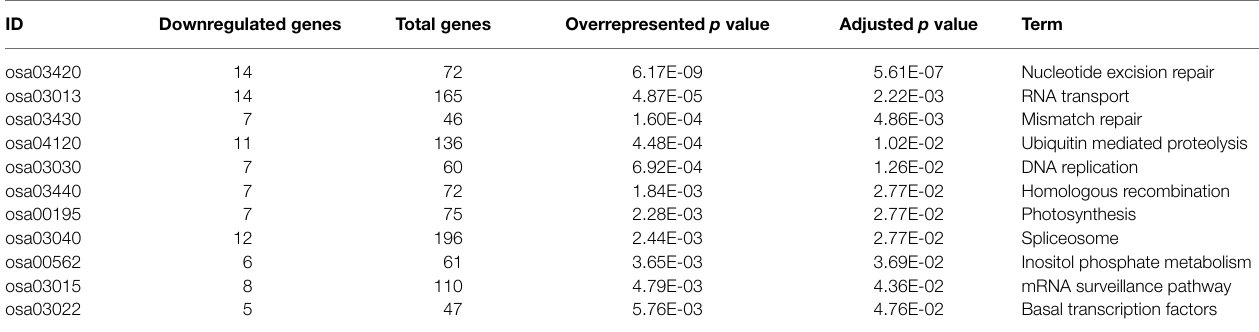
TABLE 1 | KEGG enrichment